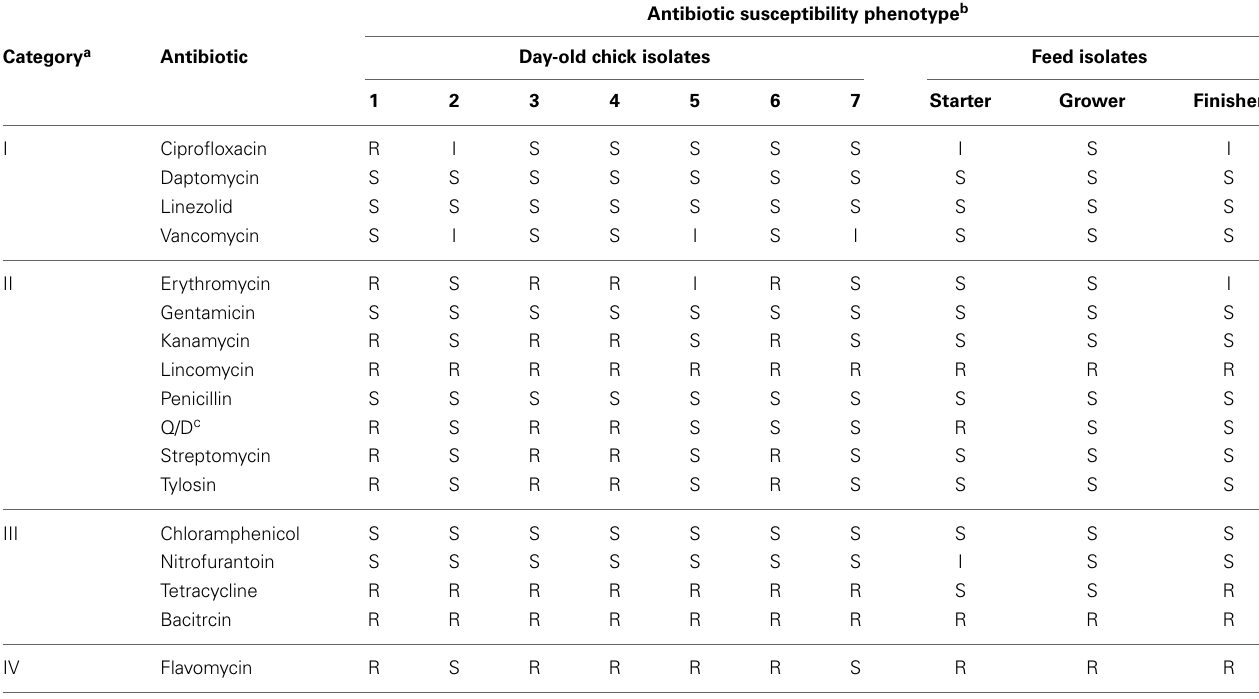
a Category indicates antibiotic ranking based on importance in human medicine. b The antibiotic susceptibility phenotypes are presented as S, sensitive; R, resistant; I, intermediary, using CIPARS susceptibility breakpoints (Government of Canada, 2013b). c